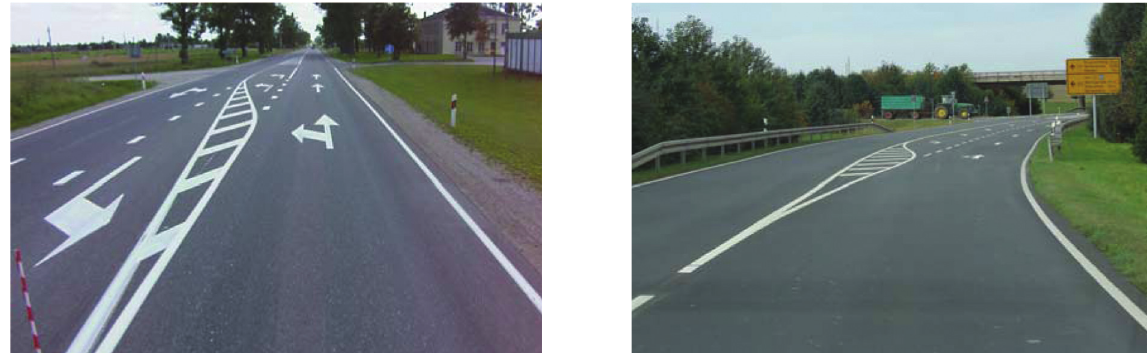
Fig. 2. Intersection with the minor road equipped with the left-turn deceleration and waiting lane